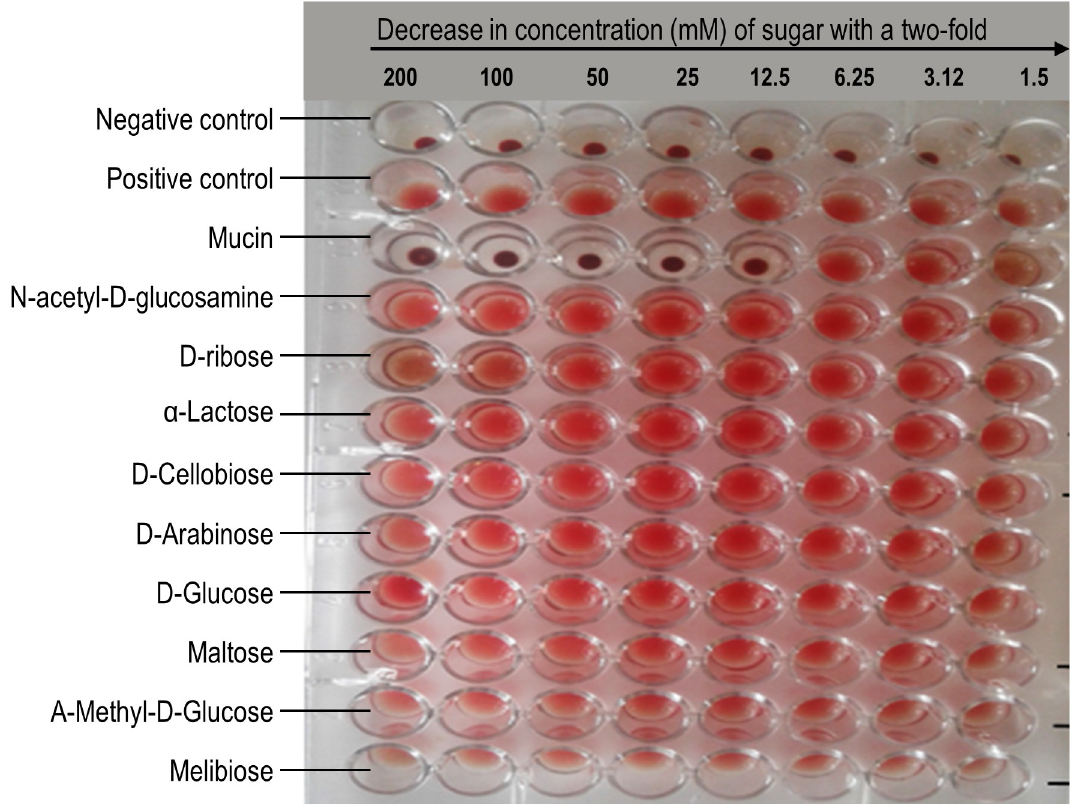
PLOS ONE | https://doi.org/10.1371/journal.pone.0265494 April 14,